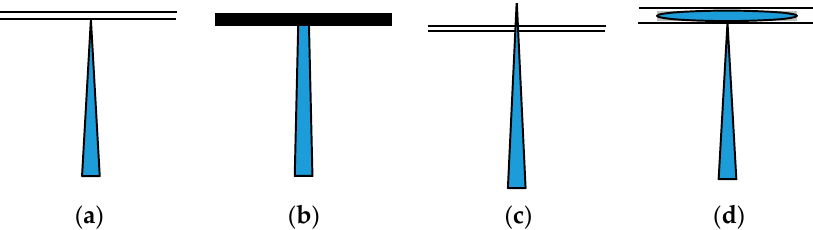
Figure 1. A schematic of different interaction modes between hydraulic fracturing (HF) and natural fracture (NF). ( a ) Approaching HF to NF. ( b ) Arresting. ( c ) Crossing. ( d ) Opening.